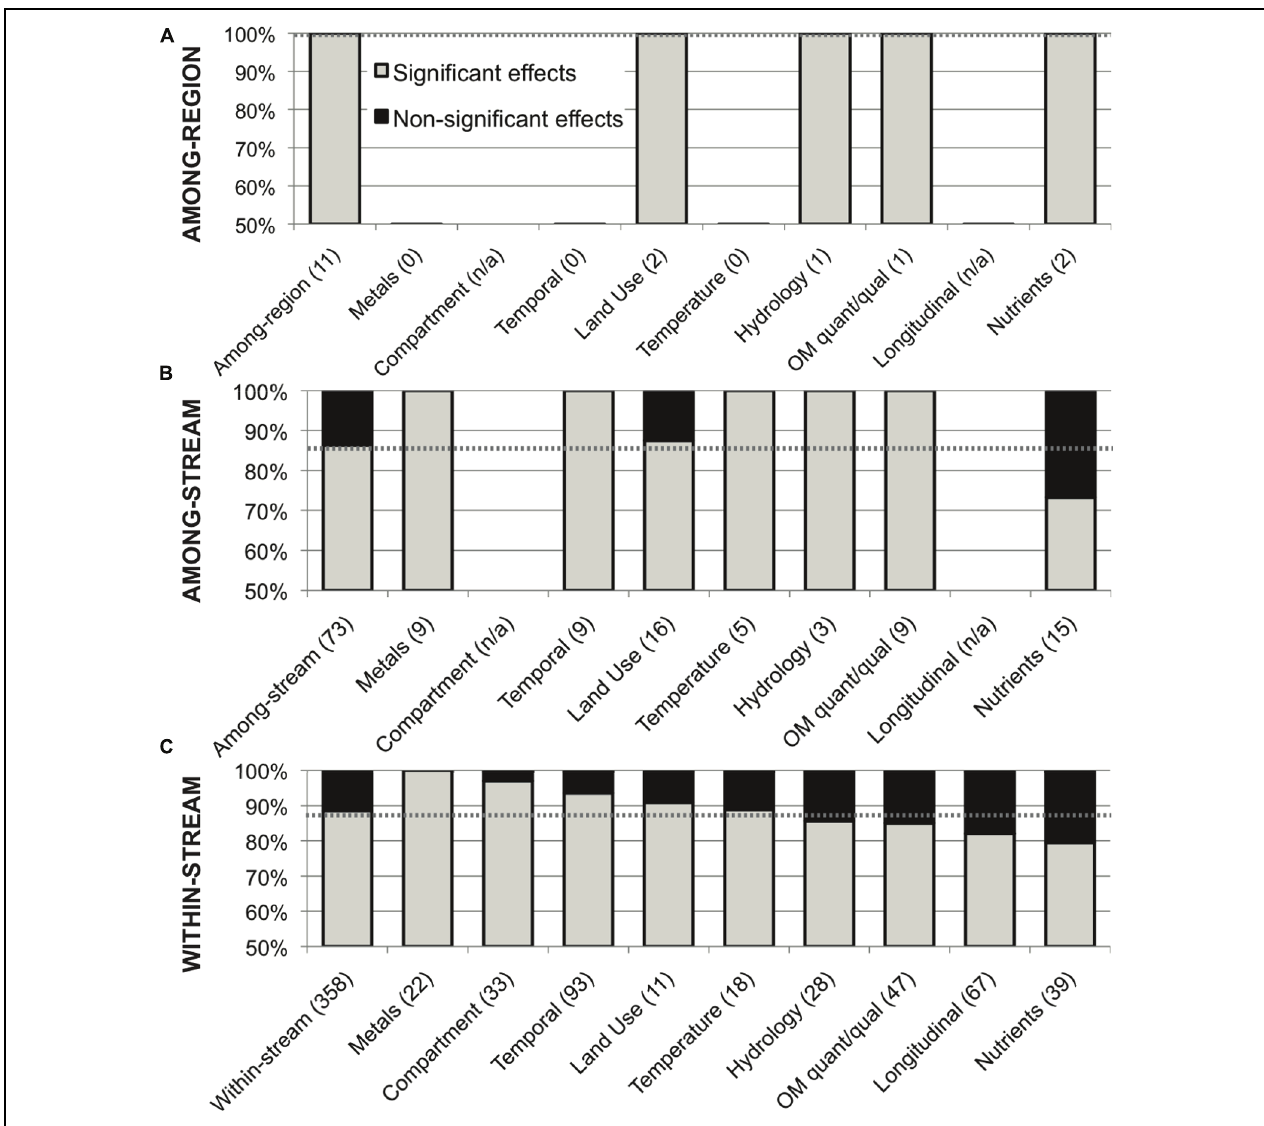
FIGURE 6 | Distribution of significant (in gray) and non-significant (in black) reported effects of categories of variation in all environmental drivers on stream microbial diversity, for (A) among-region comparisons, (B) among-stream comparisons and